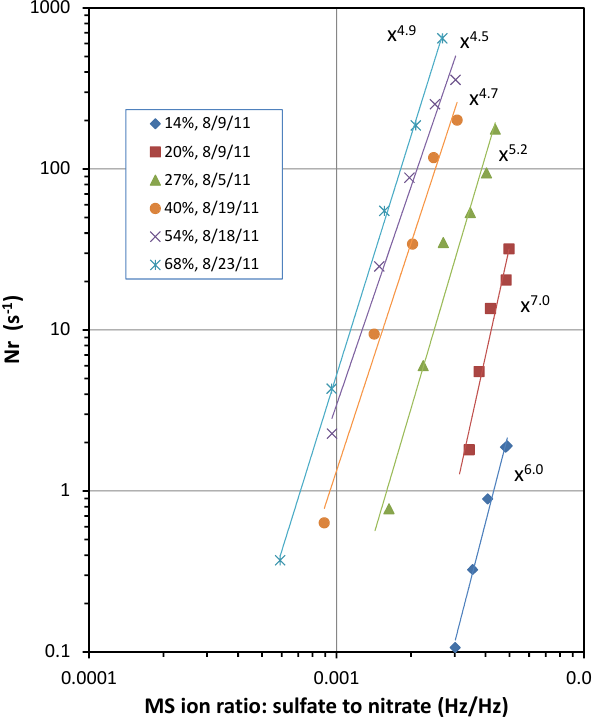
Fig. 3. Particle count rates N r vs. ion ratio (HSO − rate/NO − core ion rate) observed with the mass spectrometer. The 3 average H 2 SO 4 concentration across the ion-molecule drift region, about 1.7cm long, is given approximately by the ion ratio times 3 . 8 × 10 11 cm − 3 while the nucleation zone peak H 2 SO 4 is 5-to-10 times this. A range of RH conditions are shown here with power dependencies of